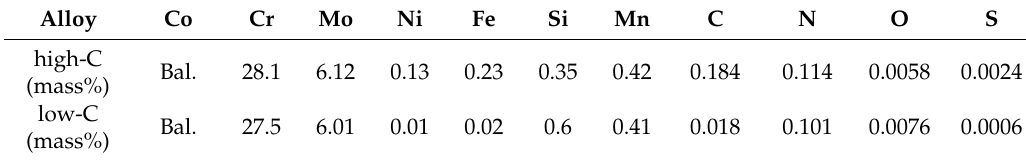
Table 1. Chemical compositions of Co-Cr-Mo alloys used in this study